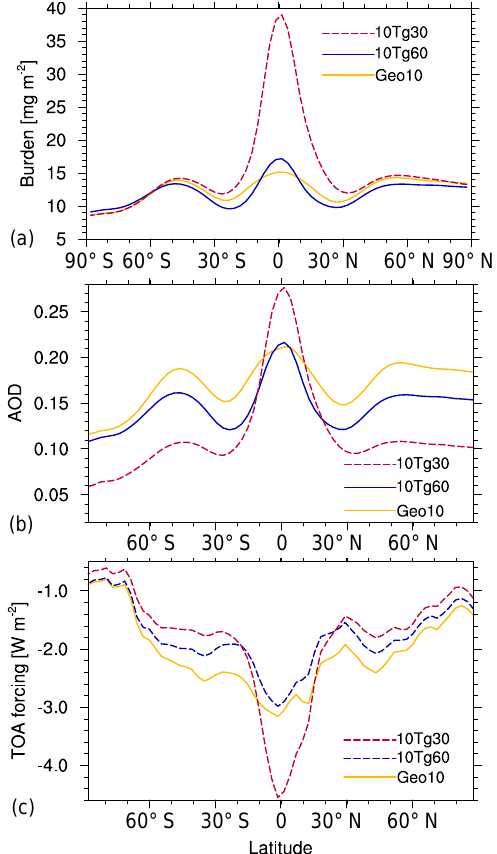
Figure 8. Zonal mean sulfate burden (a) , aerosol optical depth at 550µm (b) and top of the atmosphere forcing (c) for different ex- periments with injection rates of 10Tg ( S ) yr − 1